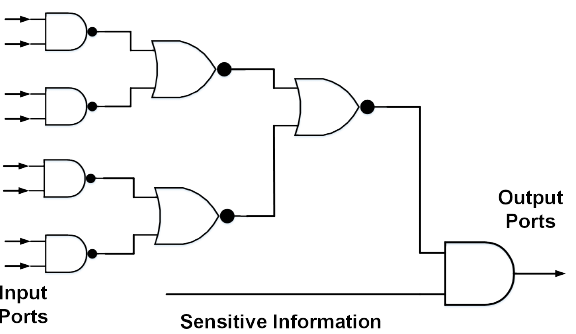
Figure 7. Design of inserted sneaky paths in ISCAS85 benchmarks.